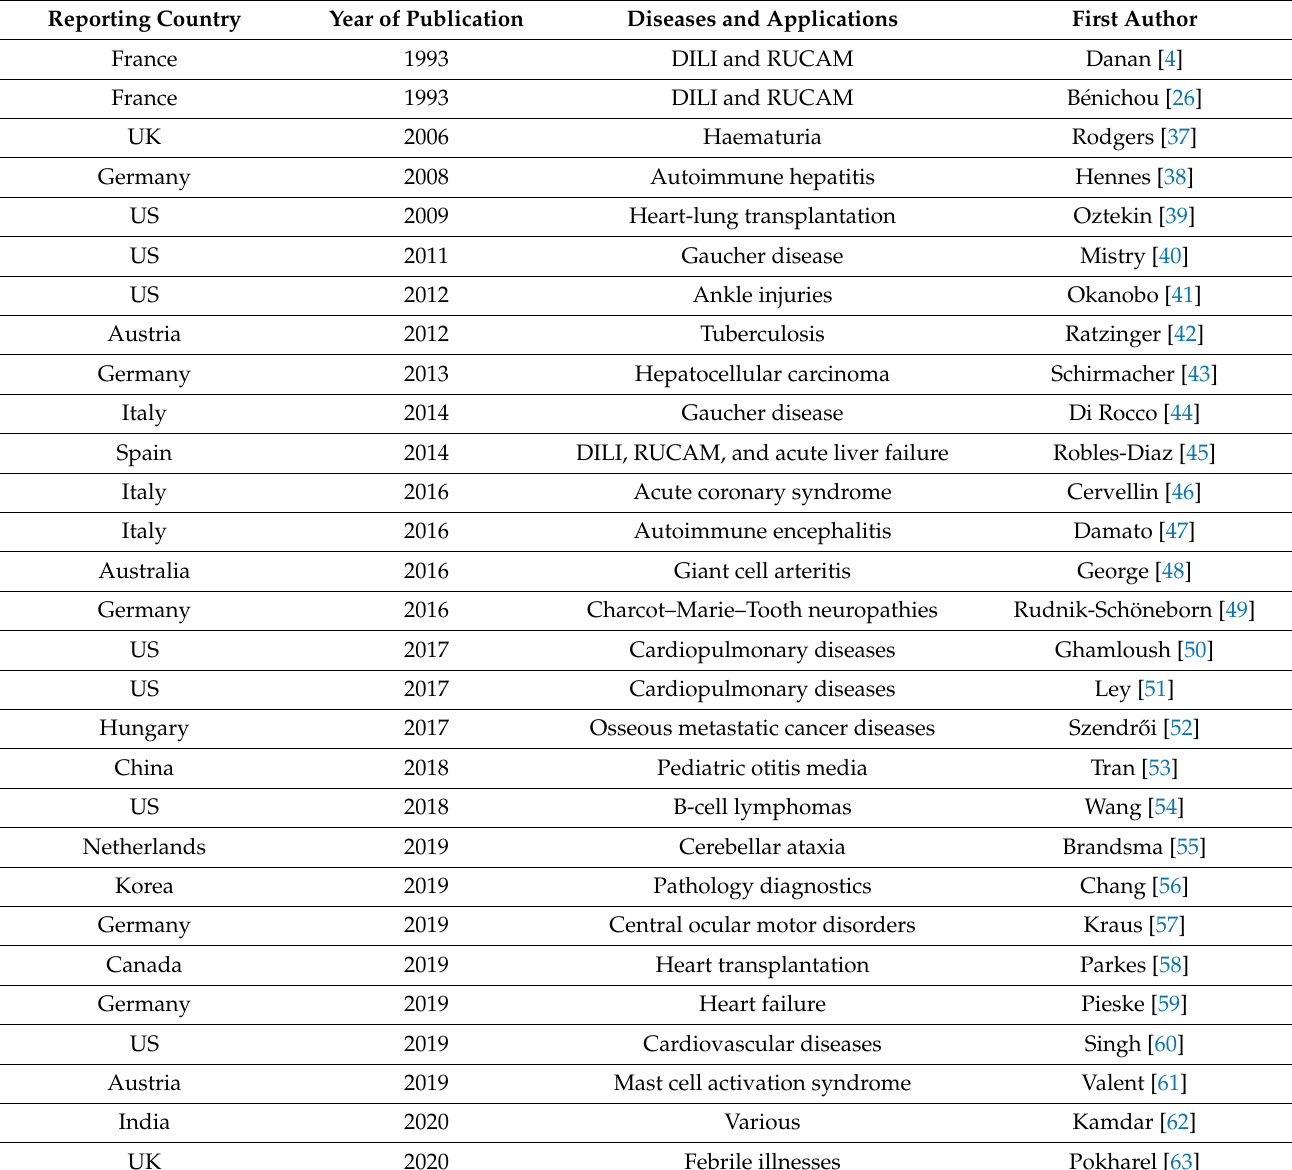
Table 2. Selected reports with diagnostic algorithms based on principles of artificial